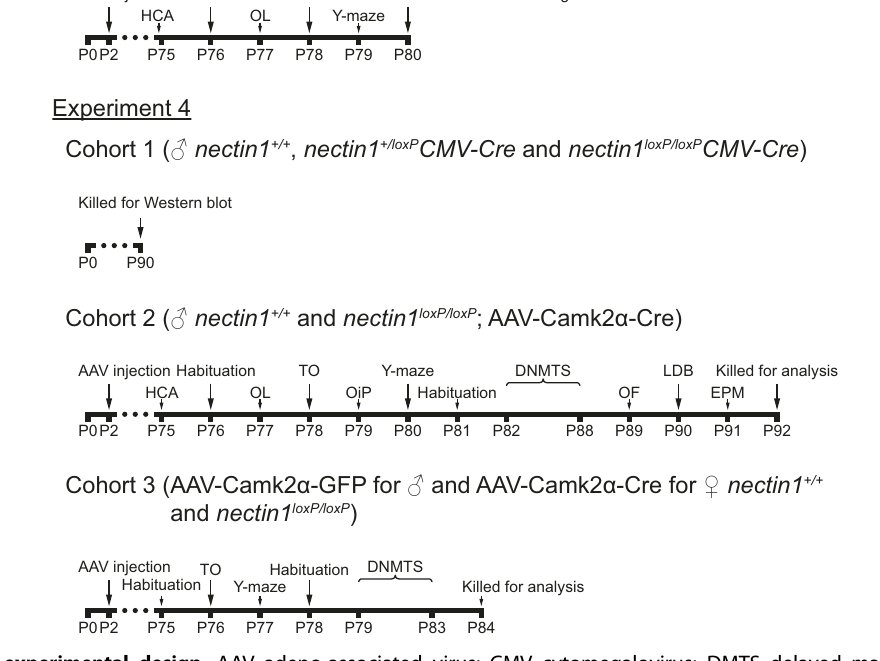
Fig. 1 Schematic of experimental design. AAV adeno-associated virus; CMV cytomegalovirus; DMTS delayed match-to-sample; DNMTS delayed non-match-to-sample; ELS early-life stress; EPM elevated plus maze; HCA home cage activity; LDB light-dark box; OF open fi eld; OiP object-in-place; OL object location; P postnatal day; TO temporal